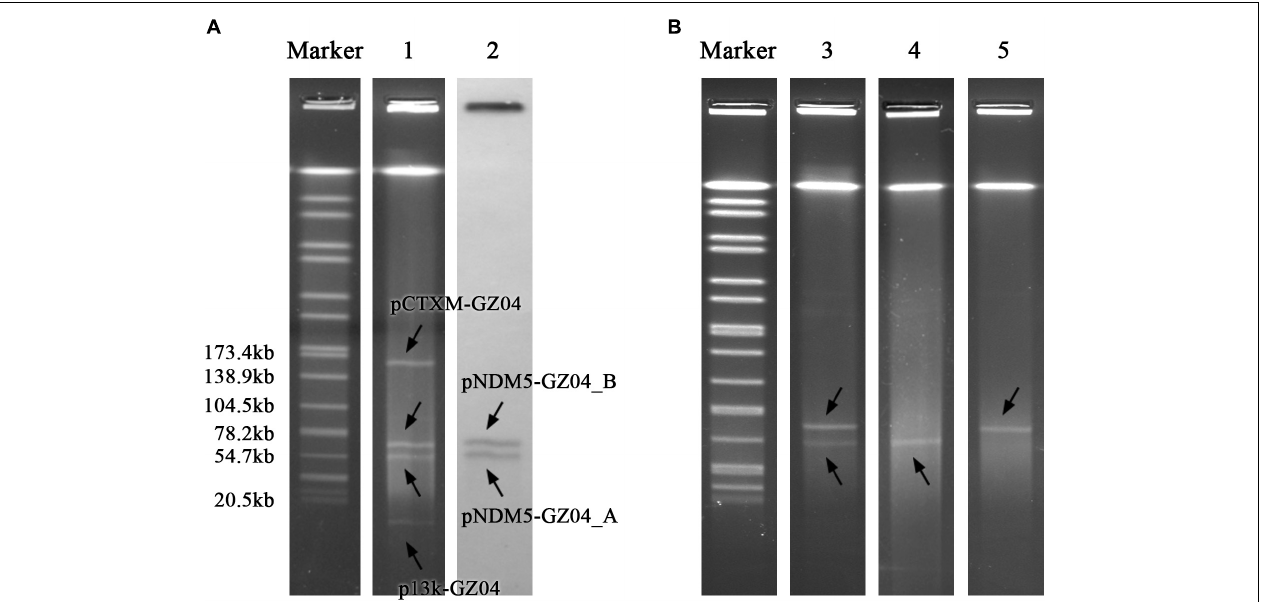
FIGURE 1 | (A) S1-PFGE pattern for strain GZ04-0086 and southern blotting for the bla NDM - 5 gene. (B) S1-PFGE pattern for E. coli J53 transconjugants. Lanes: Marker, Salmonella serotype Braenderup strain H9812 as a reference size standard; 1, PFGE result for S1-digested plasmid DNA of strain GZ04-0086; 2, southern blot hybridization with the probe specific to bla NDM - 5 ; 3, 4, and 5, PFGE patterns for S1-digested plasmid DNA of E. coli transconjugants J53-AB, J53-A, and J53-B, respectively.